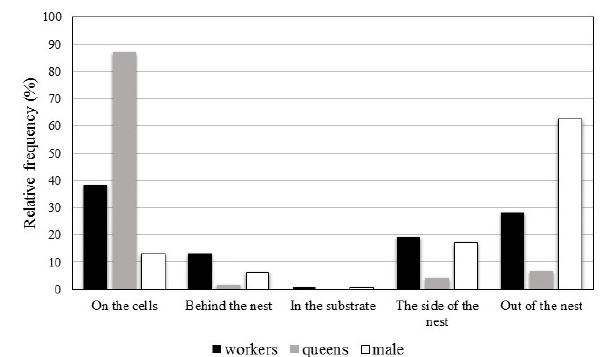
Fig 1 . Positions of females (subordinates and dominants) and males on the nests of Mischocyttarus latior (Fox,